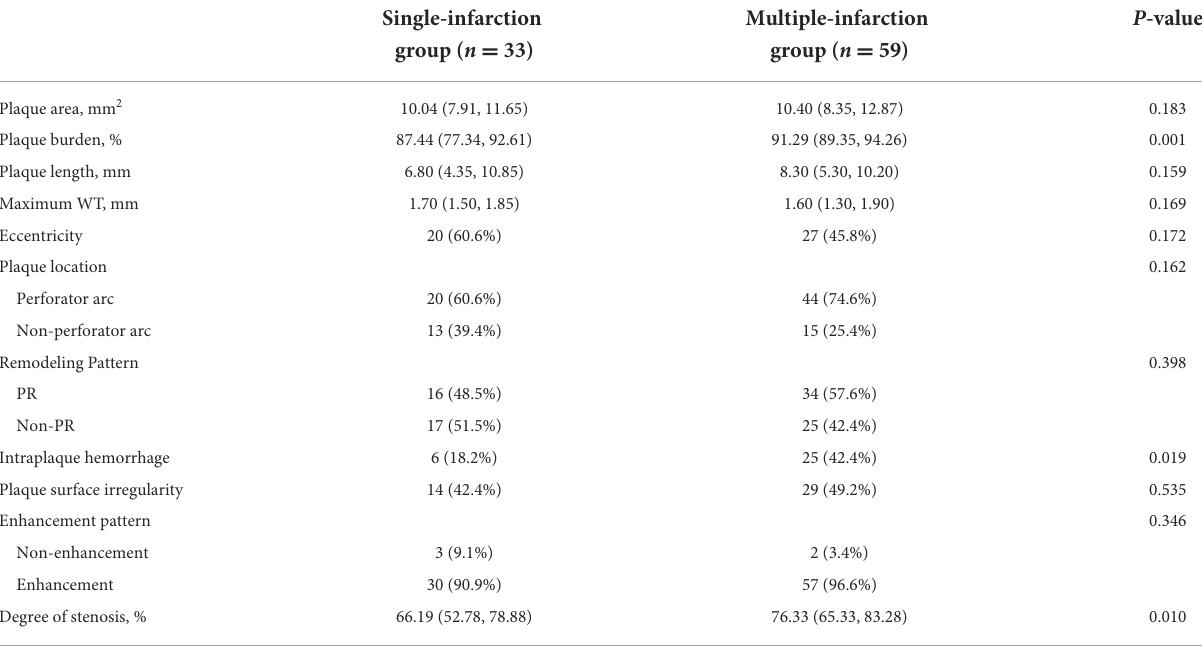
TABLE 2 Conventional HRMRI characteristics between single-infarction and multiple-infarction